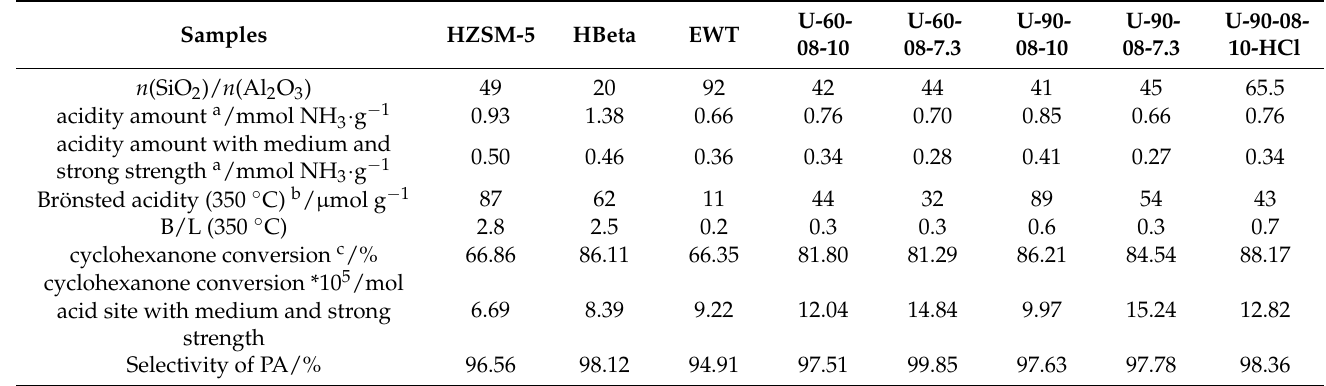
Table 4. Physico-chemical and catalytic properties of HZSM-5/Beta/EWT